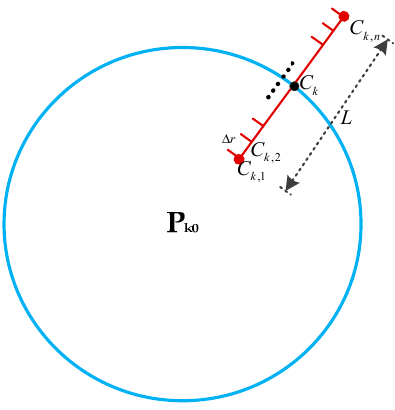
= Δ . Figure 6. The second candidates, n = L / ∆ r